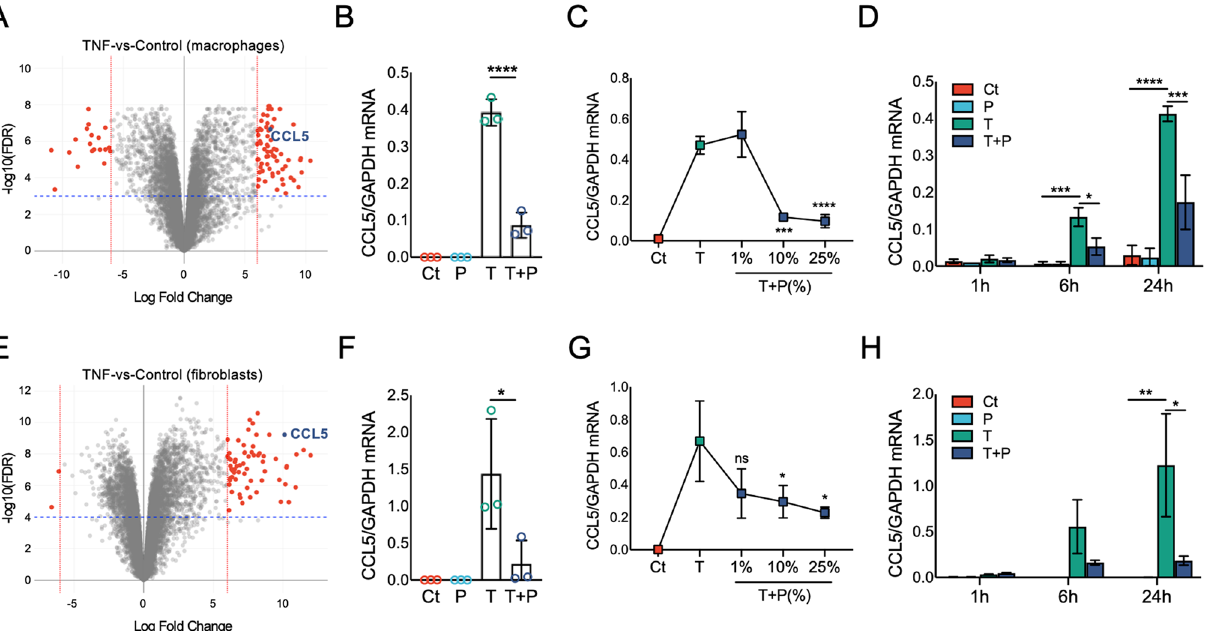
Figure 4. Dose- and time-dependent PRP modulation of the TNFα-induced CCL5 expression in macrophages and fibroblasts. ( A ) Volcano plot of differentially expressed genes comparing TNFα-treated macrophages to untreated controls. Genes with significant changes (FDR < 0.0001) and logFC > 6 are in red. CCL5 is highlighted in blue. ( B ) RTqPCR analyses in macrophages left untreated (Ct) or treated with TNFα (T) and 10% v:v PRP (P) alone or combined (T + P) for 24 h. **** p < 0.001 by ANOVA followed by Tukey’s post-hoc test. ( C ) RTqPCR analyses in macrophages left untreated (Ct) or treated with TNFα alone (T) or combined (T + P) with different concentrations (%, vol:vol) of PRP for 24 h. *** p < 0.001, **** p < 0.0001 versus TNFα by ANOVA followed by Tukey’s post-hoc test. ( D ) RTqPCR analyses in macrophages left untreated (Ct), or treated with TNFα (T), 10% (v:v) PRP (P), or TNFα + PRP (T + P) for 1 h, 6 h and 24 h. * p < 0.05, *** p < 0.001, **** p < 0.0001 by ANOVA followed by Tukey’s post-hoc test. (E ) Volcano plot of differentially expressed genes comparing TNFα-treated fibroblasts to untreated controls. Genes with significant changes (FDR < 0.0001) and logFC > 6 are in red. CCL5 is highlighted in blue. ( F ) RTqPCR analyses in fibroblasts left untreated (Ct) or treated with TNFα (T) and 10% v:v PRP (P) alone or combined (T + P) for 24 h. * p < 0.05 by ANOVA followed by Tukey’s post-hoc test. ( G ) RTqPCR analyses in fibroblasts left untreated (Ct) or treated with TNFα alone (T) or combined (T + P) with different concentrations (%, vol:vol) of PRP for 24 h. ns = not significant, * p < 0.05 versus TNFα by ANOVA followed by Tukey’s post-hoc test. ( H ) RTqPCR analyses in fibroblasts left untreated (Ct), or treated with TNFα (T), 10% (v:v) PRP (P), or TNFα + PRP (T + P) for 1 h, 6 h and 24 h. *p < 0.05, ** p < 0.01, by ANOVA followed by Tukey’s post-hoc test. RTqPCR data is represented as mean ± S.D (error bars) of 3 independent